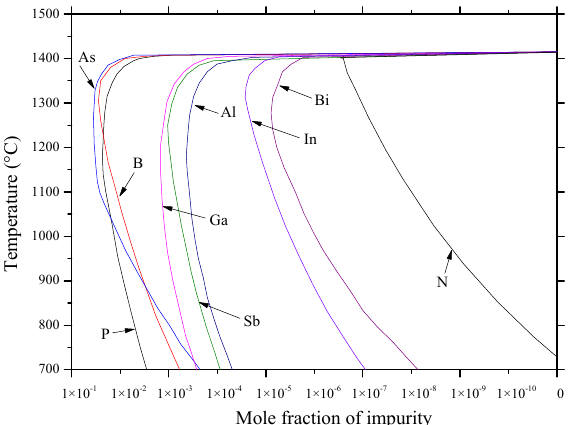
Figure 36. Summary of solid solubility of impurity atoms in silicon. Materials 2017 , 10 , 676